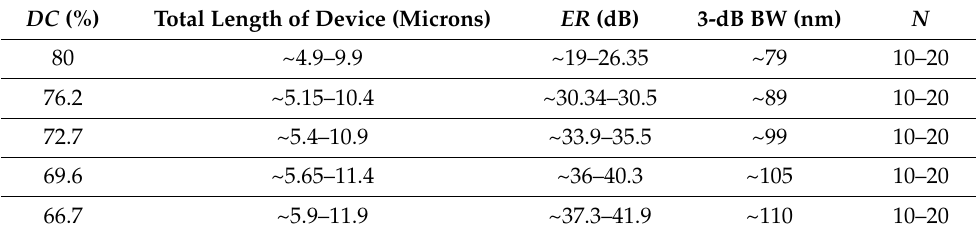
Table 5. Measured values of optical transmission losses in Wg1 and Wg2 waveguides.